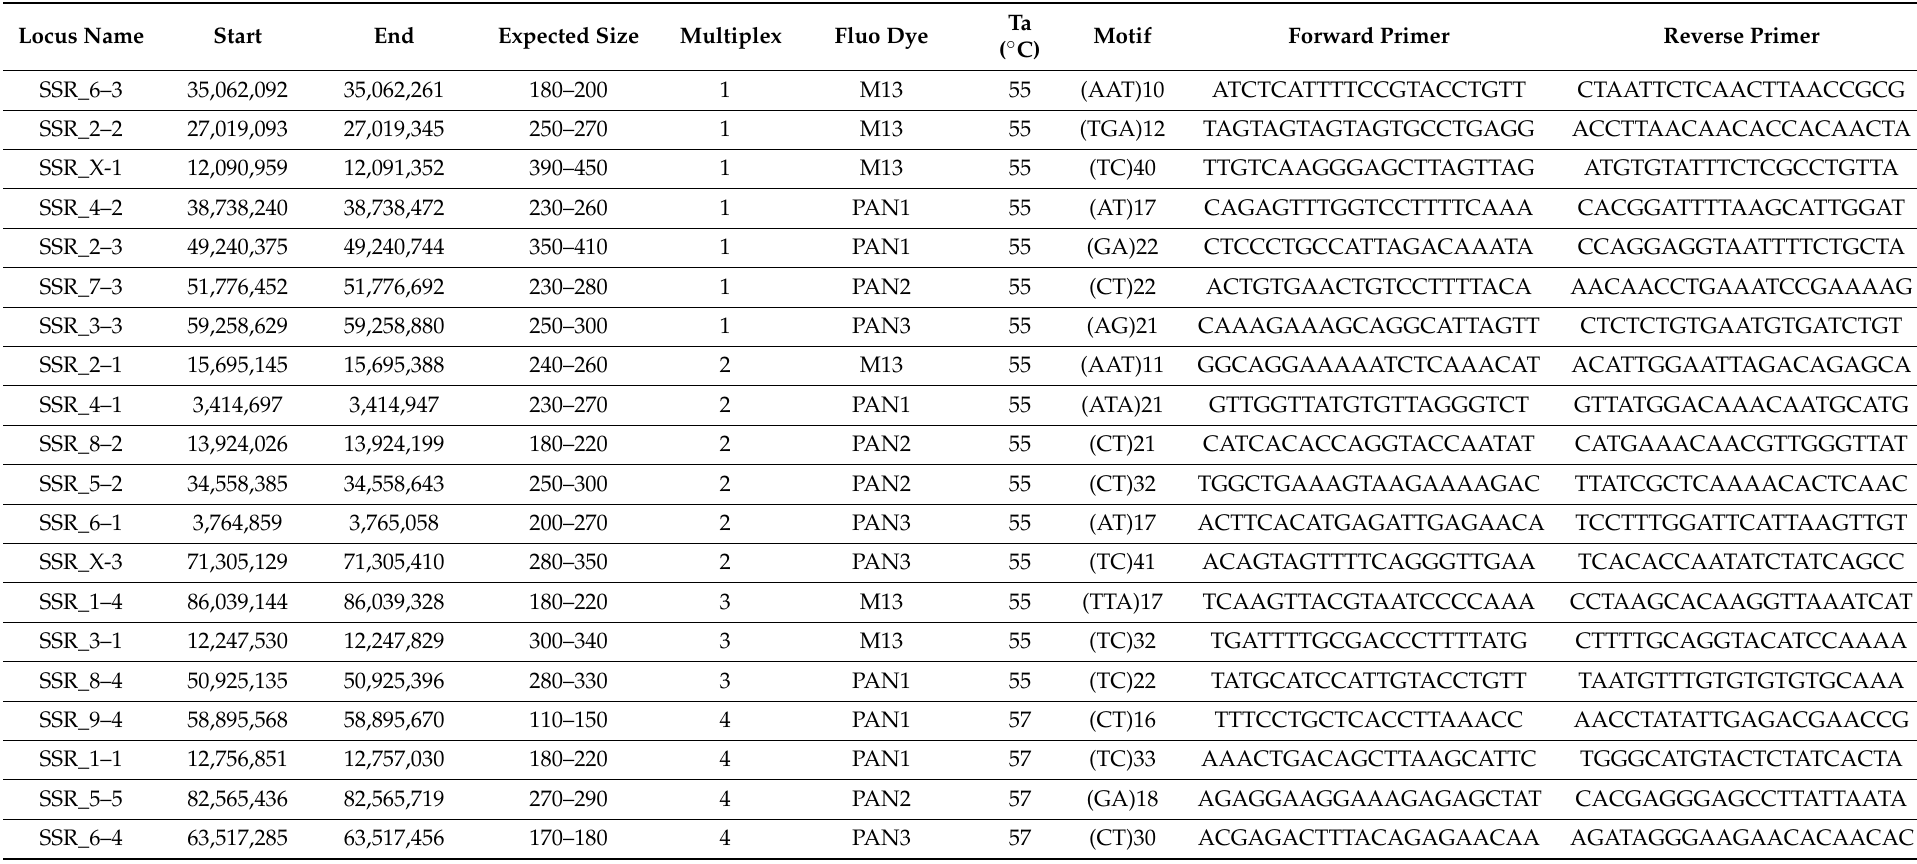
Table 5. Information on the 20 microsatellite markers validated using a core collection of high breeding value plant materials of Cannabis